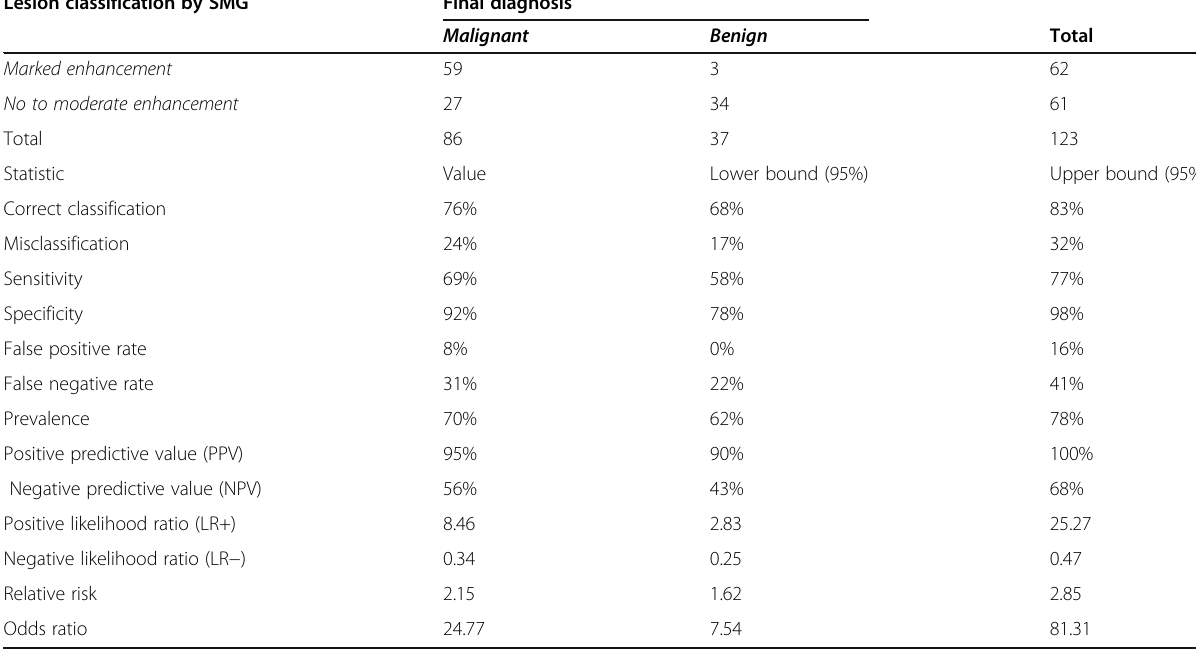
Table 16 Diagnostic accuracy of marked enhancement on CESM in the whole study cohort Lesion classification by SMG Final diagnosis